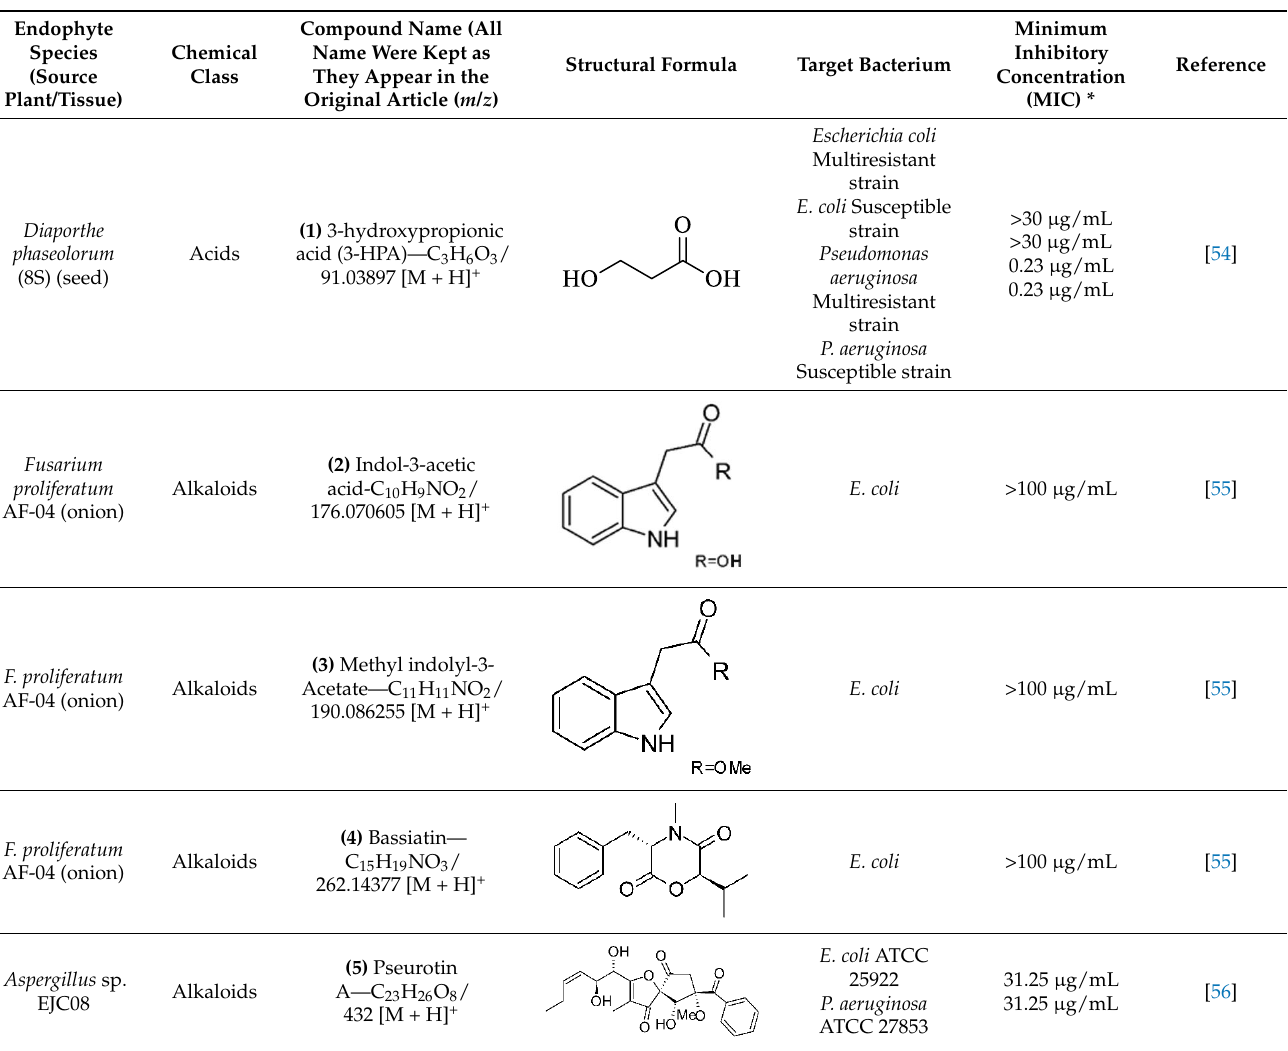
Table 1. Molecules isolated from endophytic fungi with antibacterial activity against gram-negative species. (To be continued).